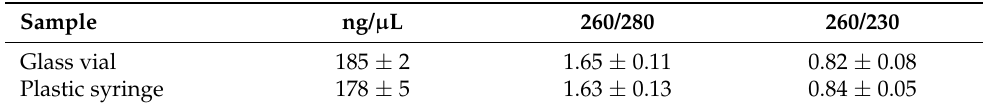
mRNA quantification and sample purity analyses by UV-vis spectrophotometry (n = 5